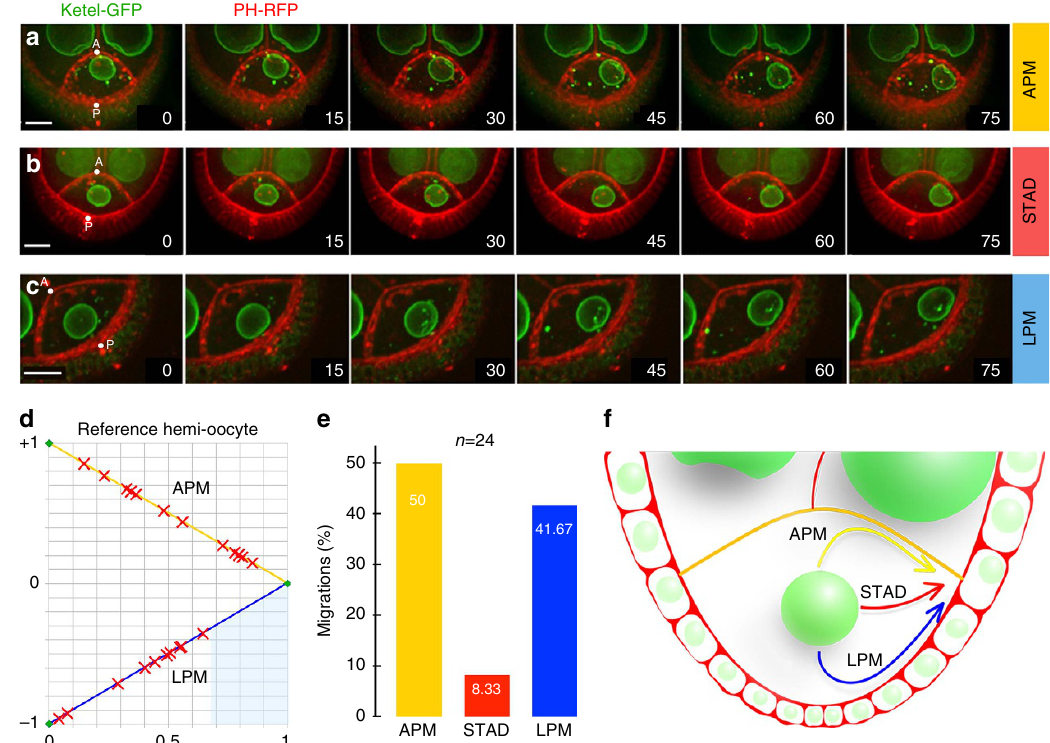
Figure 3 | The nucleus migrates to the antero-dorsal cortex through alternative migratory routes. ( a – c ) Selected frames extracted from time-lapse movies illustrating the three distinct migratory paths: along the APM ( a ), through the cytoplasm (STAD) ( b ), or along the LPM ( c ). Nuclei (green) and plasma membranes (red) are labelled by Fs(2)Ket-GFP and PH PLC- q 1 -RFP respectively. Time (min) is indicated at the lower right corner. A: anterior, P: posterior. Scale bar, 10 m m. ( d ) Normalized diagram of a reference oocyte, where the yellow and blue lines represent the APM and the LPM respectively. For 22 independent migrations, initial contact points between the nucleus and the membranes are indicated with red crosses. (For more details see Supplementary Fig. 3). Two w 2 -tests for the statistical analysis of contact point distribution were performed, with the null hypothesis H 0 of an even distribution along either the APM or the LPM. P values are 77.9% ( 44 5%) and 2.5% ( o 5%) respectively. Hence, the distribution along APM is even, whereas the LPM initial contact points fall between abscises [0; 0.67] and are excluded from abscises [0.67; 1] (blue region). ( e ) Bar plots of the distribution of the three different migration paths taken by the nuclei. ( f ) Schematic illustration of the three nuclear migratory tracks in the